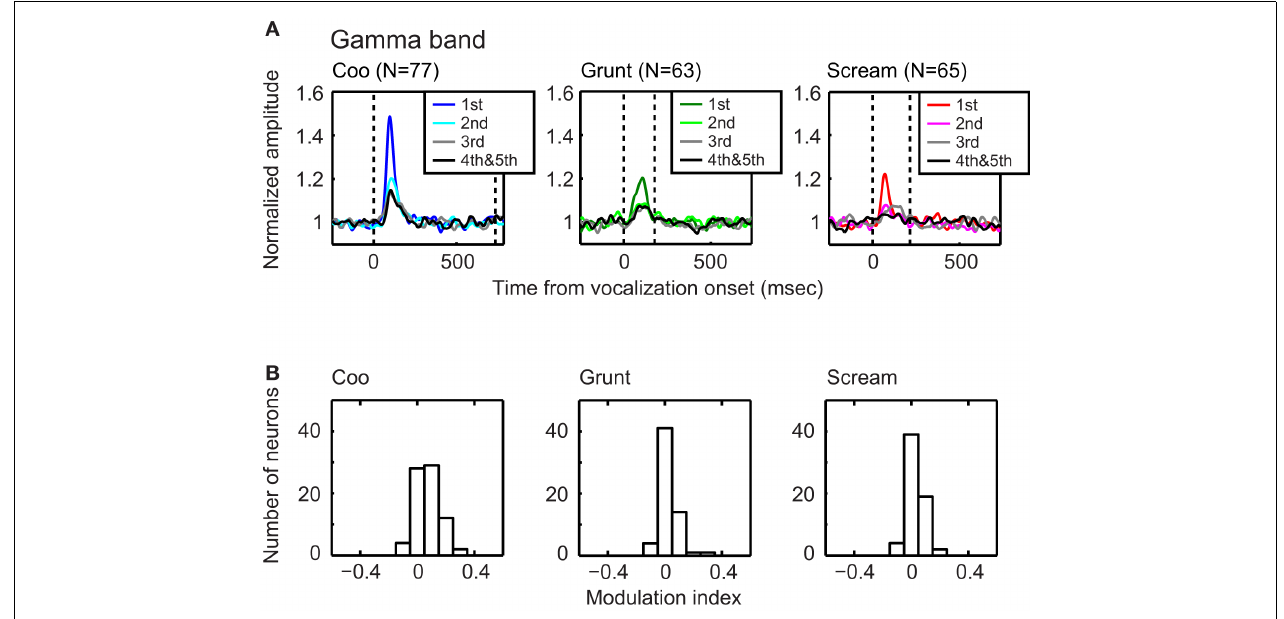
vocalization onset (i.e., the vertical dotted line at time t = 0).The second dotted line indicates vocalization offset.The data in (B) show the distributions of modulation-index values as a function of vocalization: coo (left; n = 77 sites), grunt (middle; n = 63 sites), and scream (right; n = 65 sites).The mean value of each distribution is reliably ( t -test; p < 0.05) greater than zero, indicating that, for each vocalization, the amplitude of the gamma band reliably decreased with repeated presentations of the